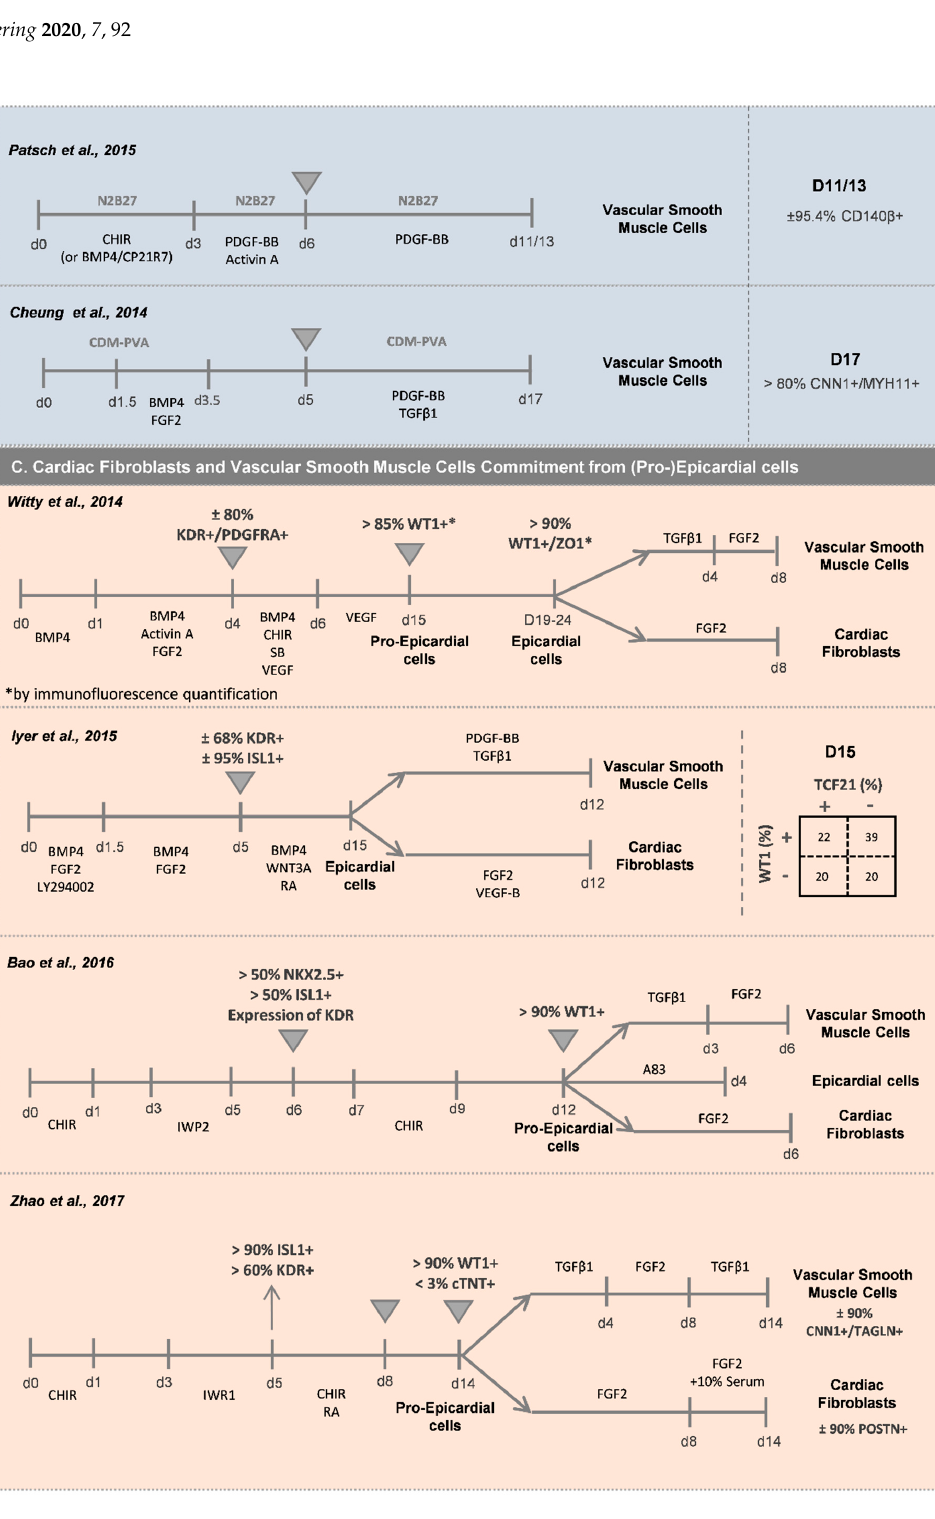
Figure 4. Current in vitro strategies to generate non-myocyte cardiac cells from hPSCs and respective molecular markers. Protocols for generation of ( A ) vascular progenitor cells and endothelial cells (ECs); ( B ) cardiac fibroblasts (CFs) and vascular smooth muscle cells (vSMCs) from cardiac mesoderm progenitors; ( C ) CFs and vSMCs from pro-epicardial-like cells. VECs, venous endothelial cells; AECs, arterial endothelial cells; P, passage; AA, ascorbic acid; DMEM / F12 + SP, DMEM / F12 + chemically defined lipid concentrate + ITS + Glutamax + monothiol glycerol + AA; ECGM-MV2, Endothelial Cell Growth Medium MV2, PromoCell; ESFM, Endothelial Serum-Free Medium, GIBCO; ECGM-2, Endothelial Cell Growth Medium 2,